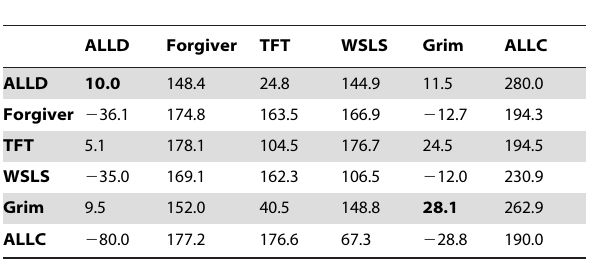
Table 1. Payoff matrix for the most relevant